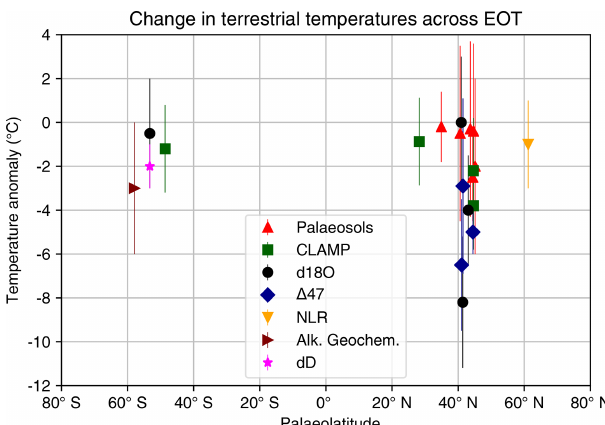
Figure 4. Summary of terrestrial air temperature change across the EOT from proxies palaeosols, CLAMP, δ 18 O, (cid:49) 47 , nearest living relative (NLR), alkaline geochemistry and δ D (hydrogen isotopes). Data are compiled from Boardman and Secord (2013), Colwyn and Hren (2019), Eldrett et al. (2009), Fan et al. (2017), Gallagher and Sheldon (2013), Héran et al. (2010), Herman et al. (2017), Hinojosa and Villagrán (2005), Hren et al. (2013), Kohn et al. (2004), Kvaˇcek et al. (2014), Lielke et al. (2012), Meyers (2003), Page et al. (2019), Passchier et al. (2013), Roth-Nebelsick et al. (2017), Sheldon and Tabor (2009) and Zanazzi et al. (2007). Where possible, we apply the same method as in Fig. 3; i.e. the “late Eocene” is taken the average temperature from 38 to 33.9Ma, the “early Oligocene” is taken as the average from 33.9 to 30Ma and the temperature change shown here is the difference. However, in a number of cases only a relative temperature change across the EOT was given in the orig- inal literature. We therefore limit our compilation to temperature anomaly only. The compilation shown above is provided in digital form in Table S2 in the